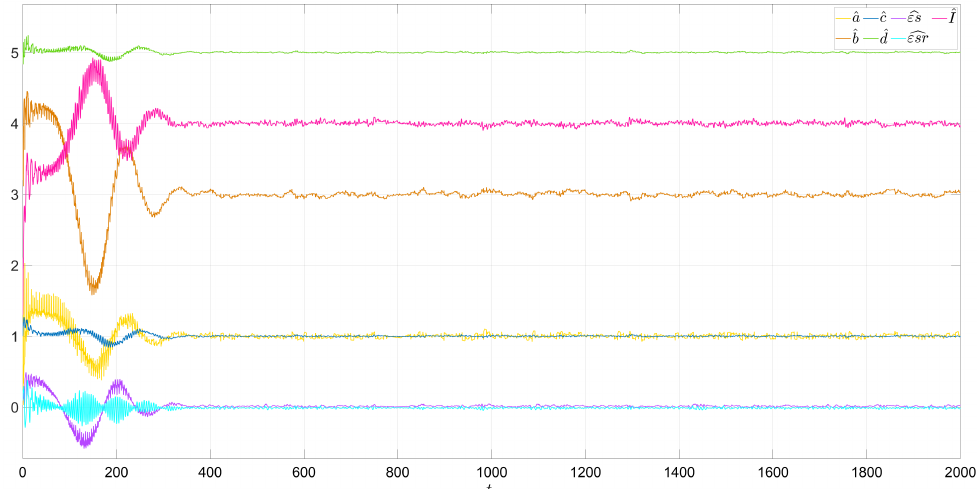
Figure 9. Identification with bounded Gaussian disturbance ( µ = 4, σ 2 = 0.01 )